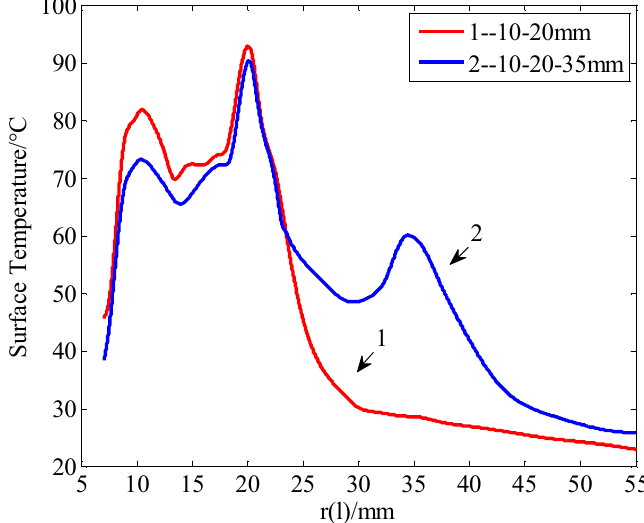
Figure 11. Numerical simulation of surface temperature distribution of insulators with dry bands in di ff erent positions.